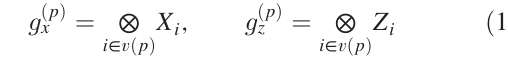
carried out at the beginning of the sequence; analysis rotations (green) are carried out before projective readout